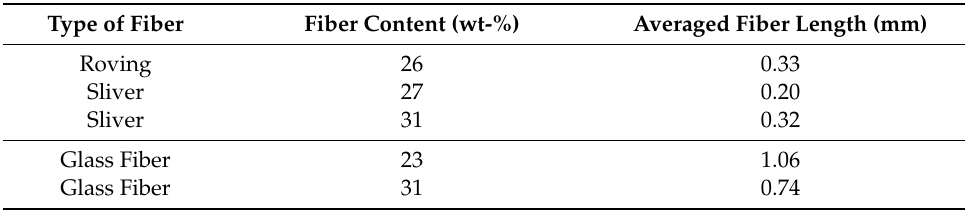
Table 4. Settings of the preliminary